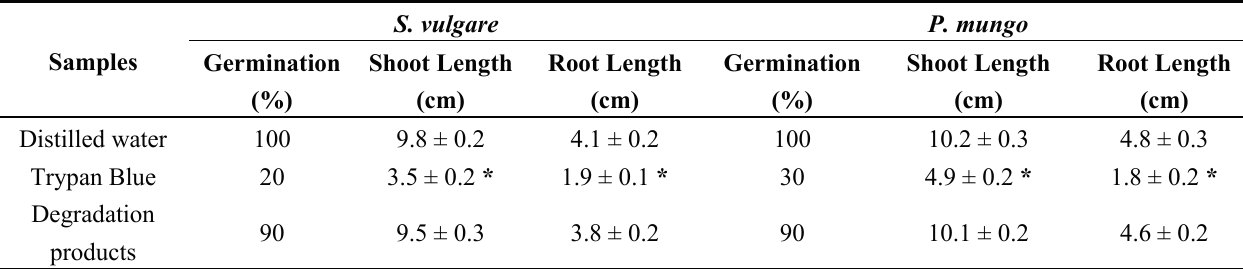
Table 5. Phytotoxicity of Trypan Blue (50 mg L − 1 ) and its degradation products extracted after degradation (24 h) by microbial consortium.